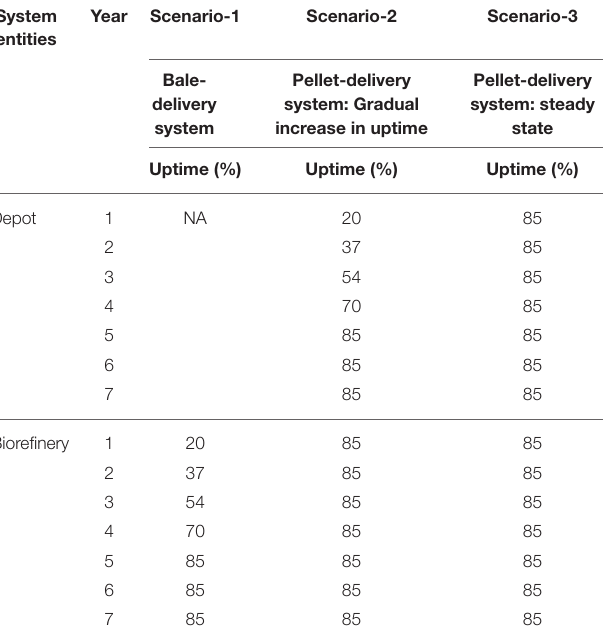
TABLE 1 | Scenarios analyzed to evaluate the impact of operational